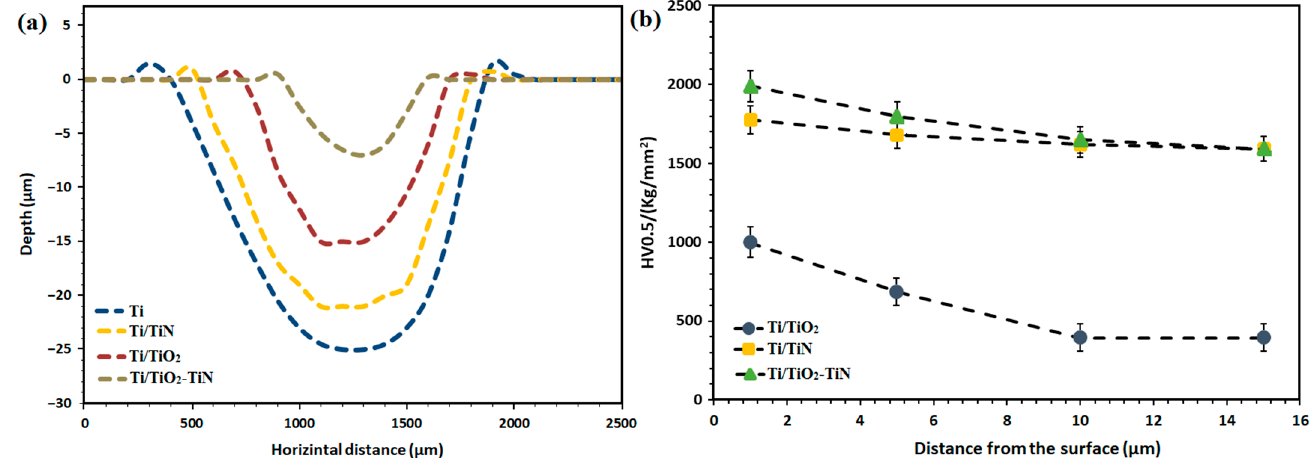
Figure 7. ( a ) Linear profiles of wear depth of uncoated and coated samples, and ( b ) Depth mi- cro-hardness profile obtained on the coated samples by PEO and gas nitriding. hardness profile obtained on the coated samples by PEO and gas